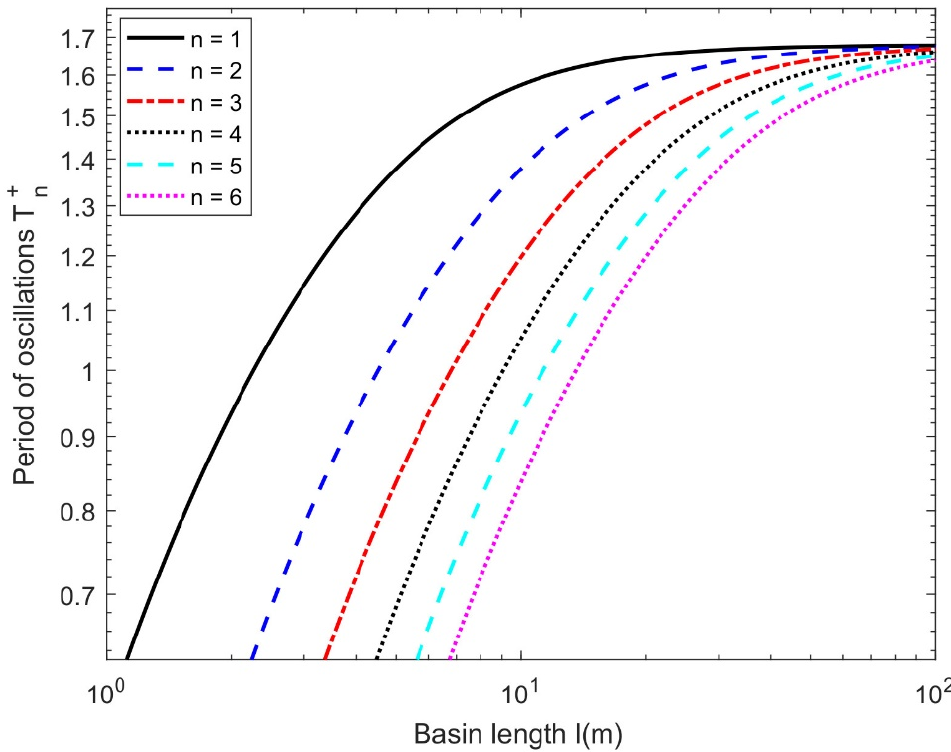
T + , of floating flexible plate with 0 30 θ= . Figure 18. Effect of modes on the period of oscillation, T + n , of floating flexible plate with θ = 30 0 n